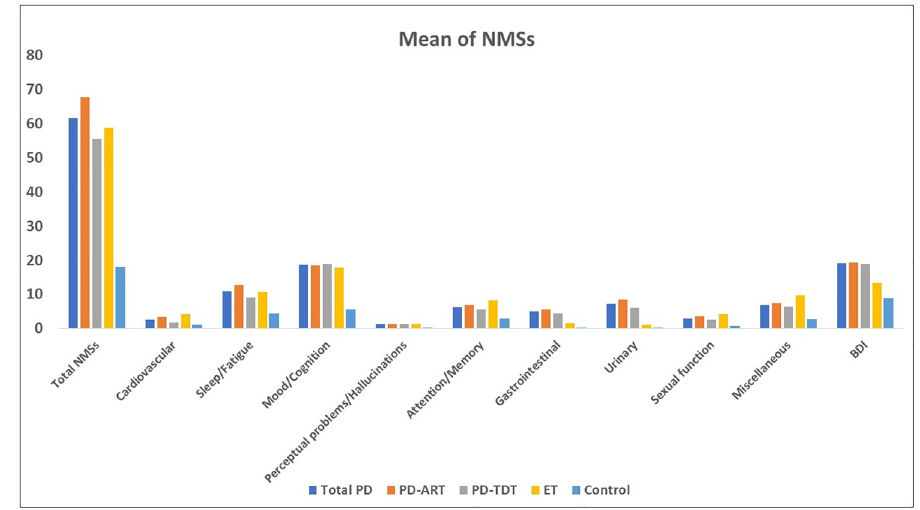
Fig 1. Means of NMSs in the study groups.